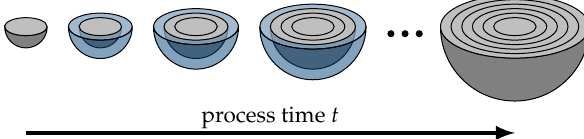
Figure 1. Scheme of layer-wise particle growth.